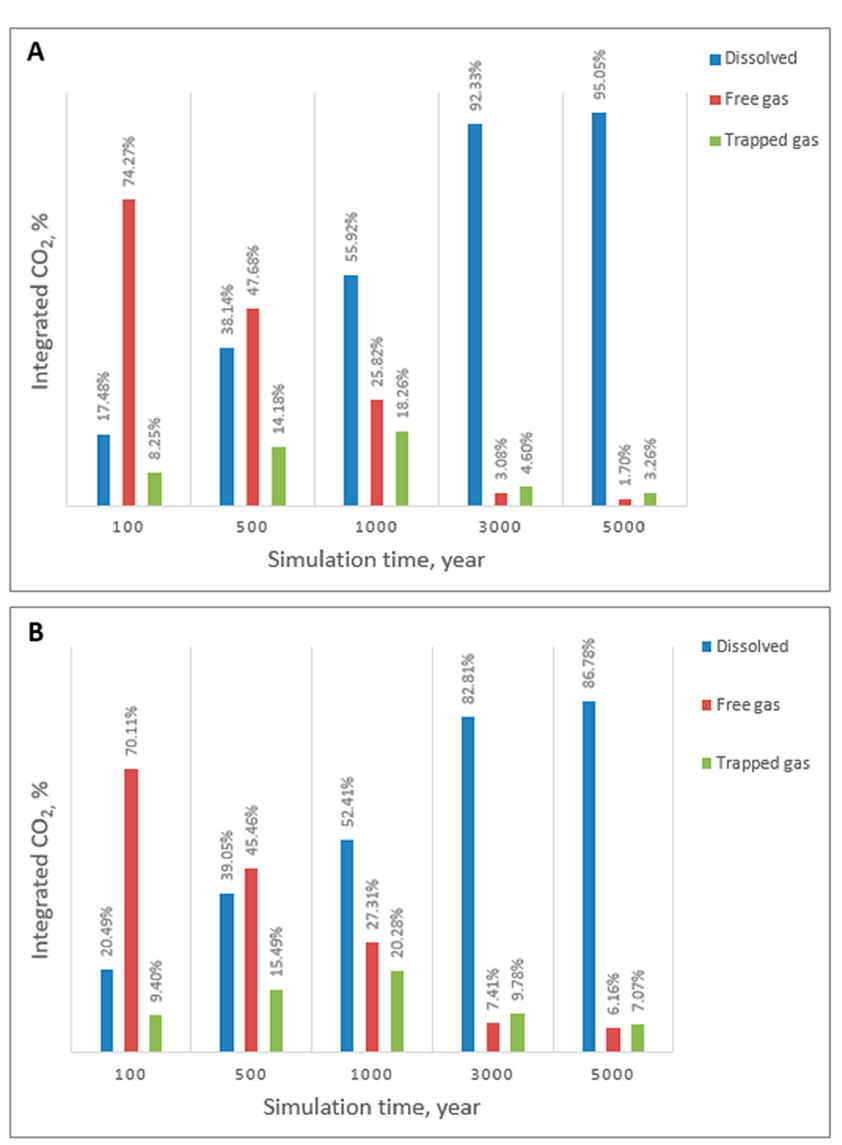
Figure 3. Various phases of integrated CO 2 trends in: ( A ) homogeneous porous domain (case 1); ( B ) uniform heterogeneous domain (case 2) in Table 3.